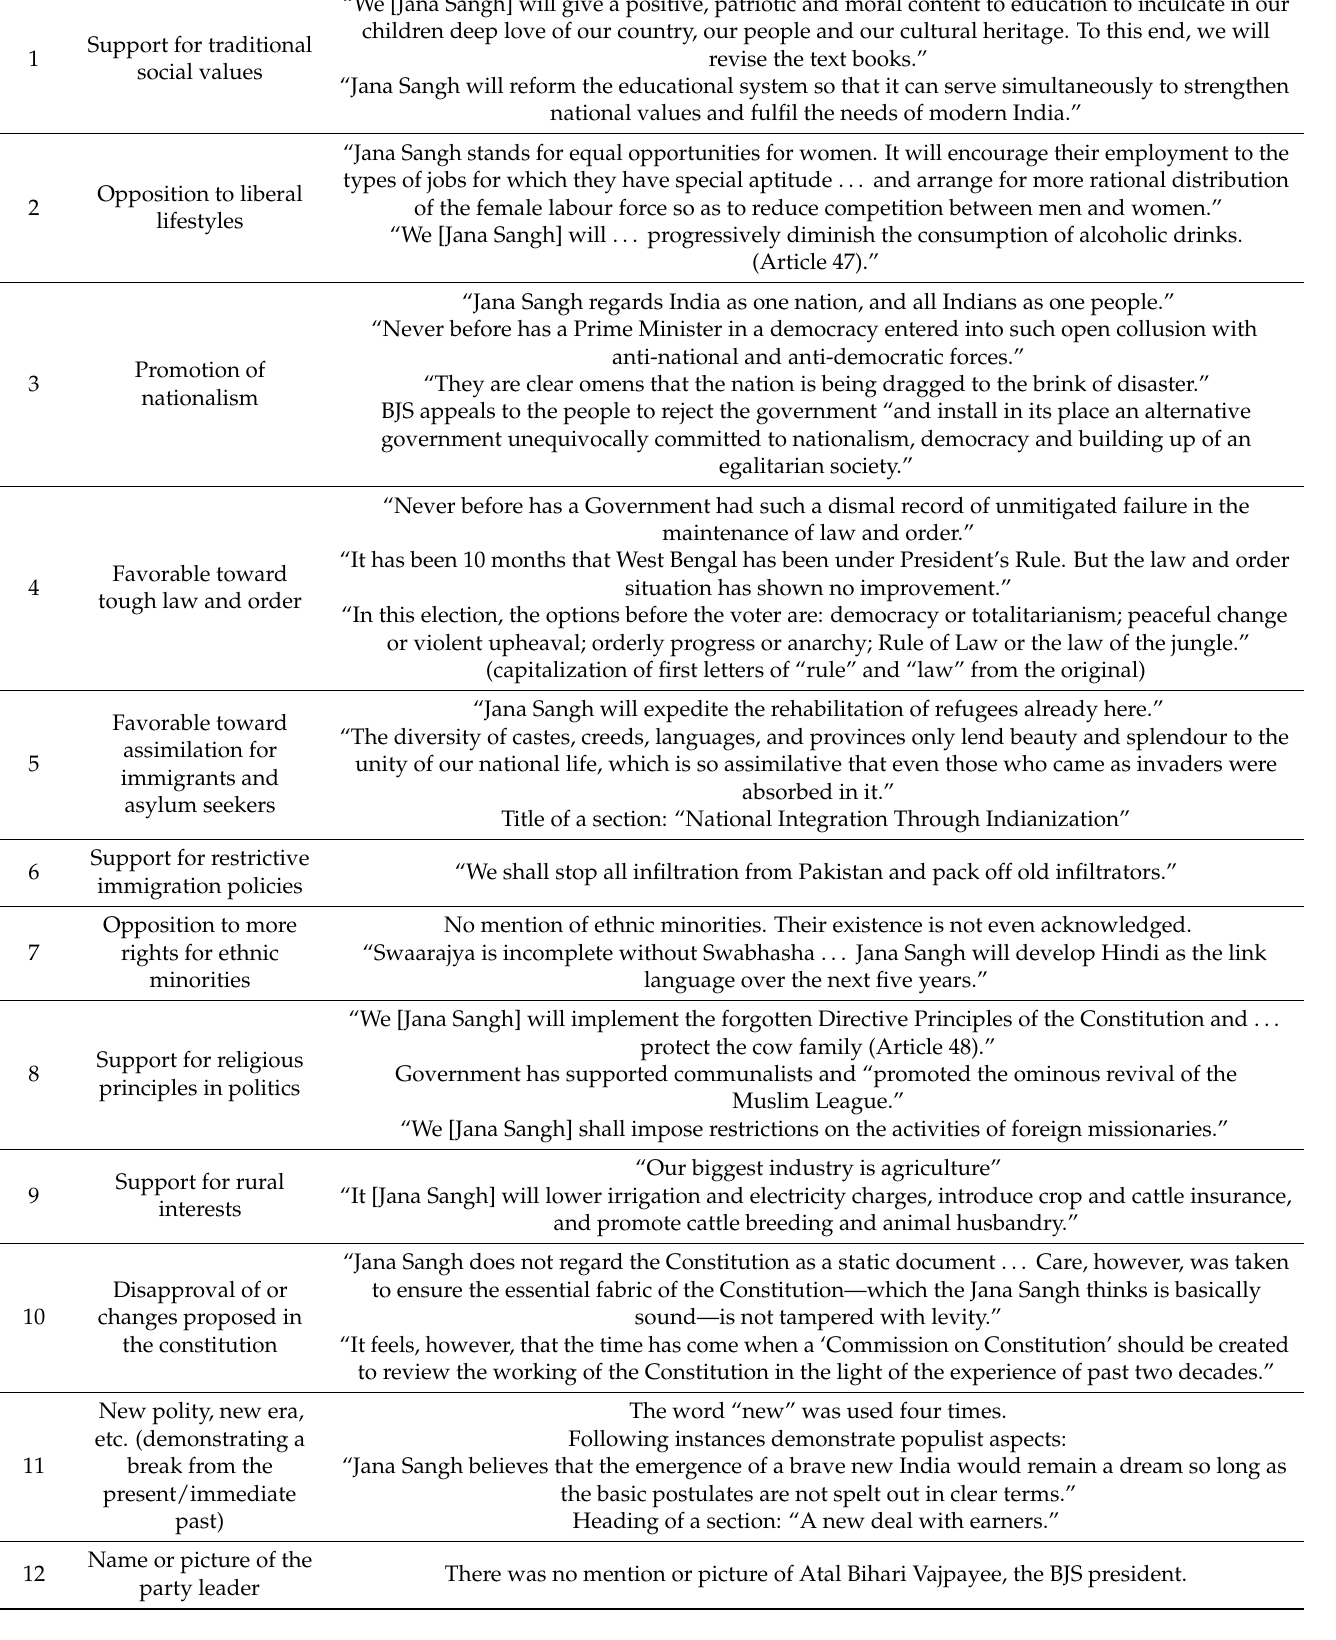
Table 3. Hindu nationalism and populism in Bharatiya Jana Sangh based on 1971 manifesto (BJS 1971).